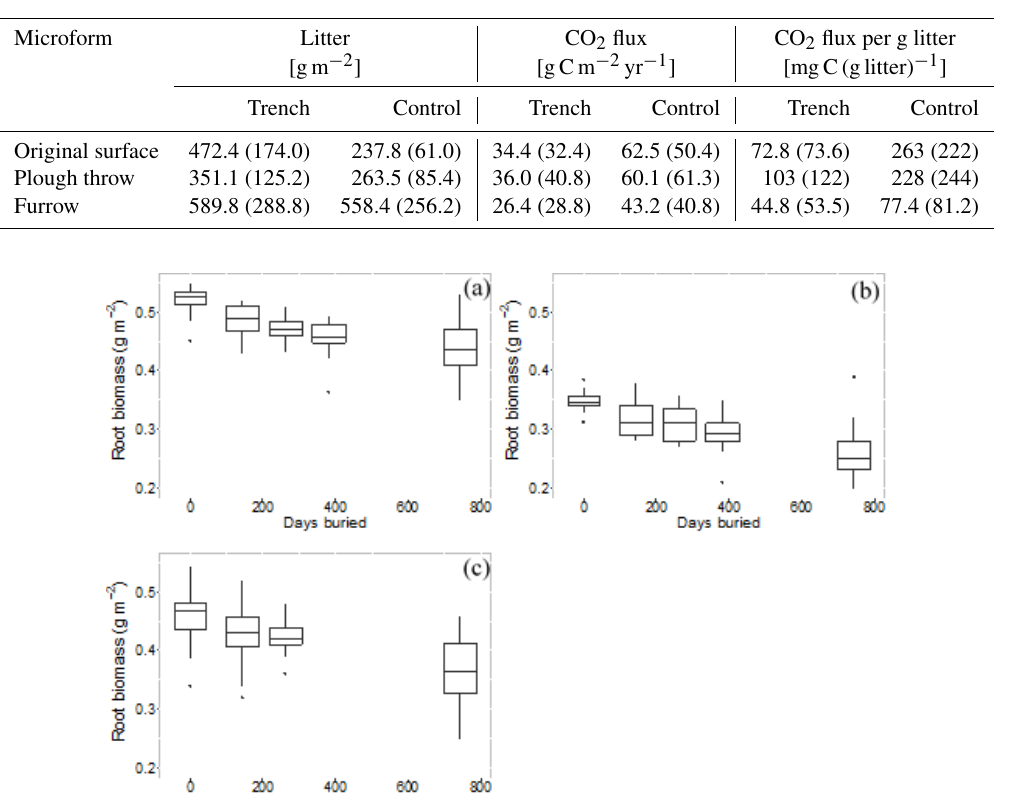
Figure 7. Root mass remaining in root bags over number of days buried, for each root size class averaged across all microforms. (a) Root size < 2mm, (b) root size 2–5mm and (c) root size > 5mm.